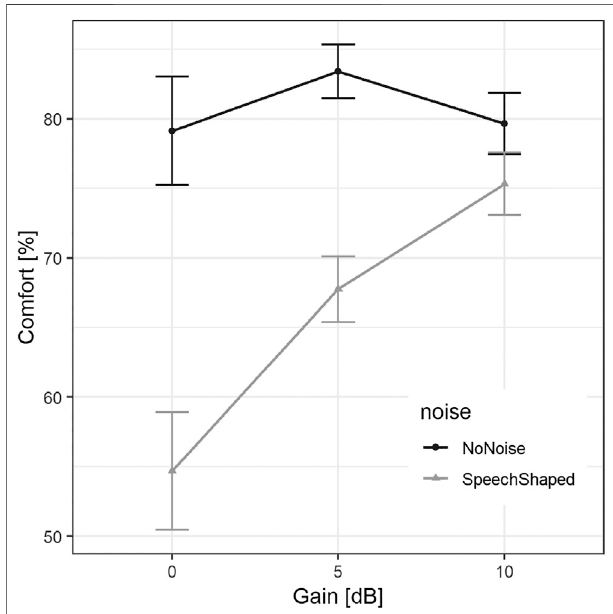
FIGURE 3 | Mean self-reported vocal comfort in % (0 (cid:2) ‘ not at all comfortable ’ , 100 (cid:2) ‘ extremely comfortable ’ ) across participants per gain level. The error bars indicate ± standard